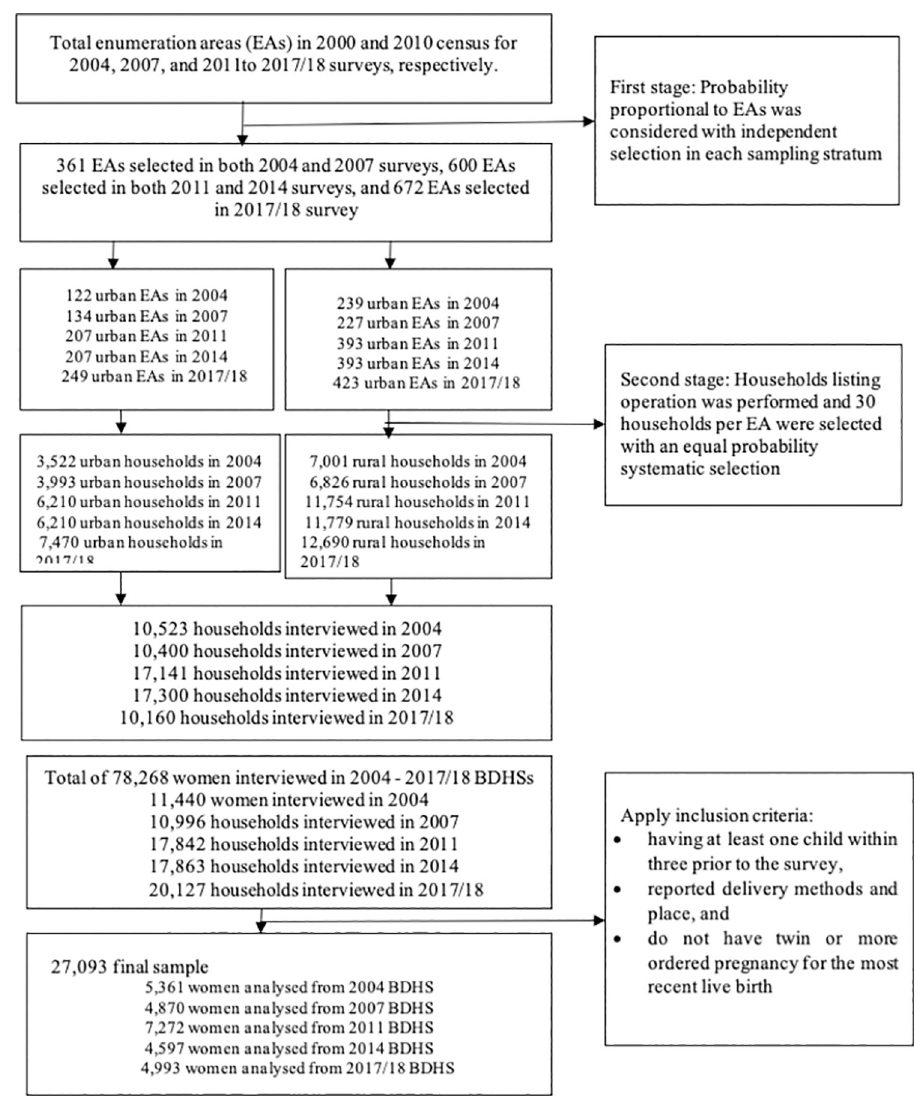
Fig 1. Flow chart of the study participants selection from the Bangladesh Demographic and Health Surveys,